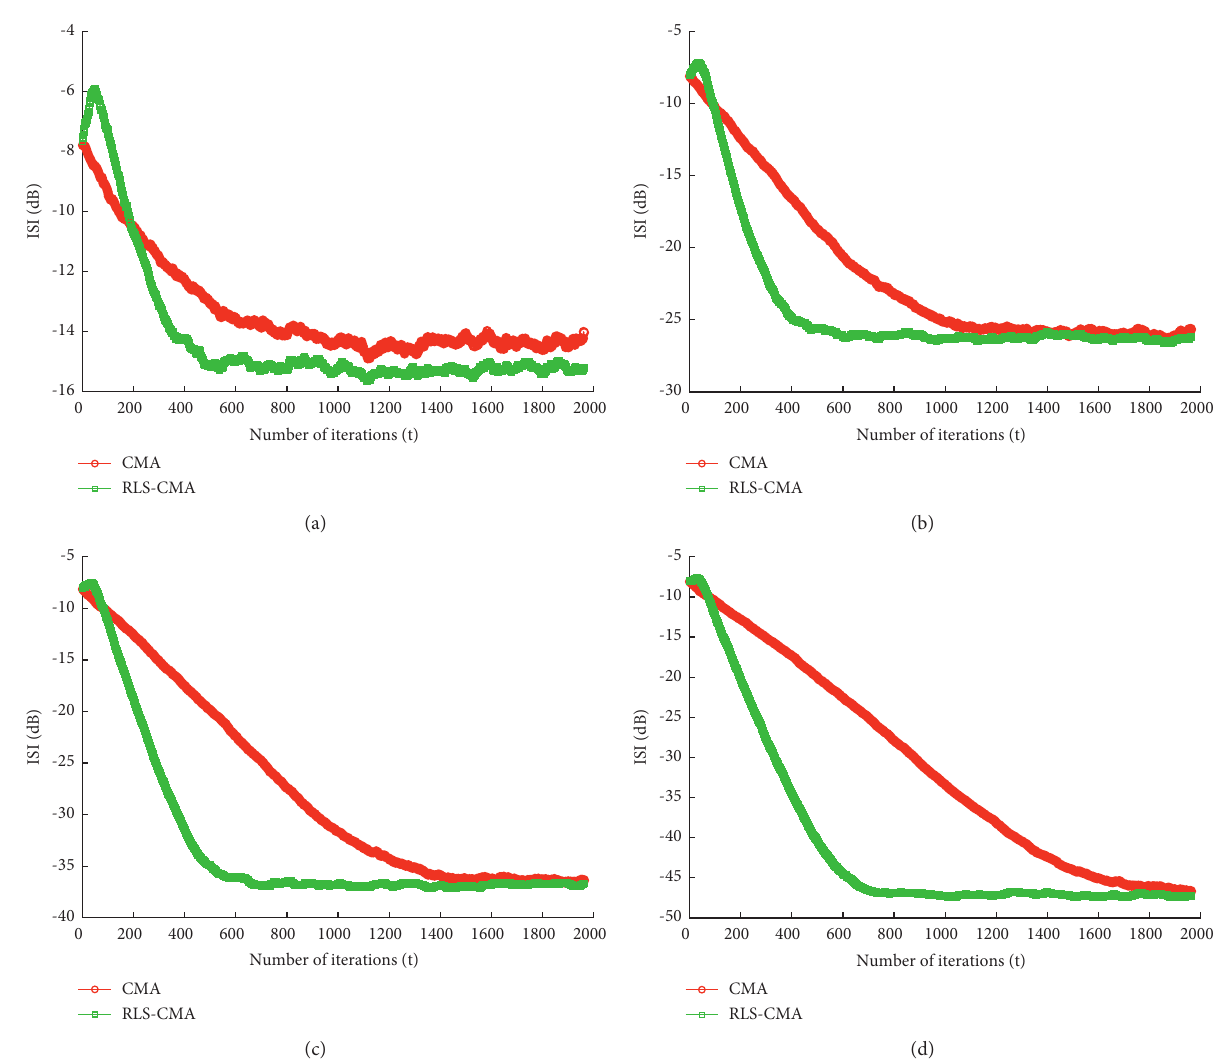
Figure 8: Relationships between the number of iterations and the ISI of the 8PSK-modulated signal obtained for different blind equalisation algorithms at SNR � 15–45dB: (a) SNR � 15dB. (b) SNR � 25 dB. (c) SNR � 35dB. (d) SNR �